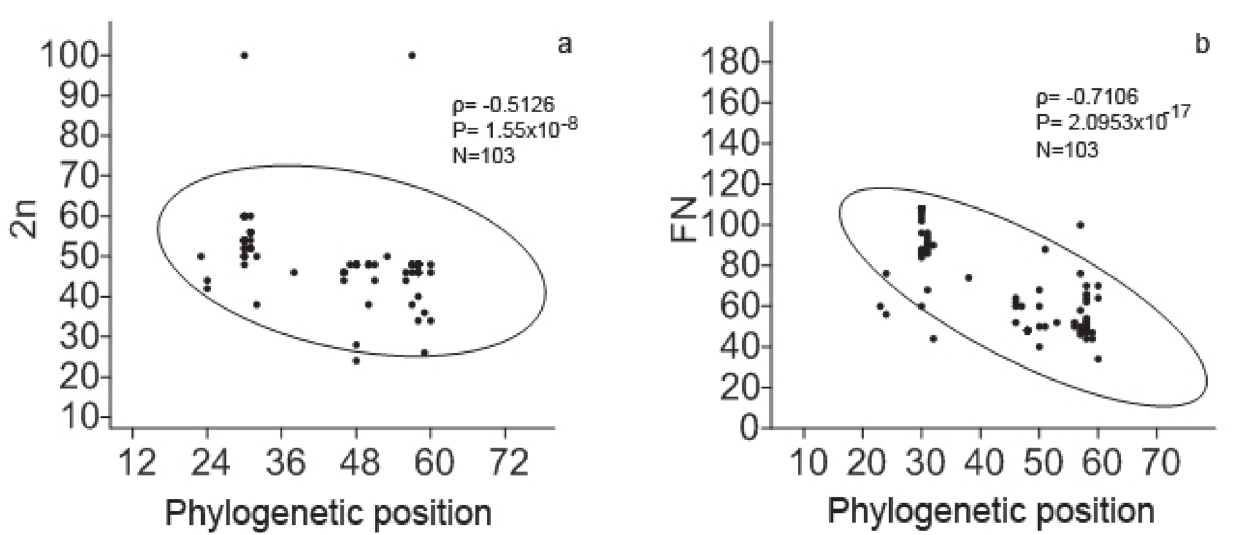
Fig. 1. Scatter-plot of (a) diploid number (2n) and (b) fundamental number (FN), against the phylogenetic position of Actinopterygii families presented by Nelson (2006) for 103 fish species. Ellipses with 95% confidence are used as a correlation